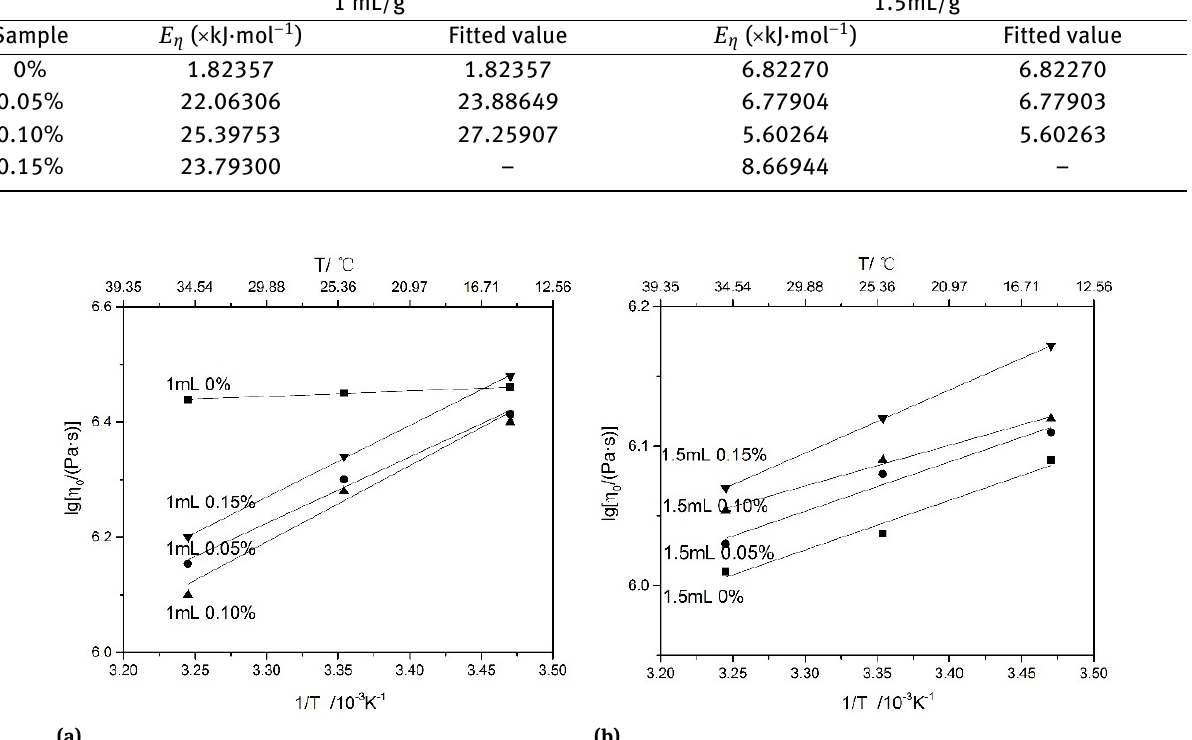
Figure 7: lg[ η 0 /(Pa · s)] vs. 1/T at different concentration of graphene.